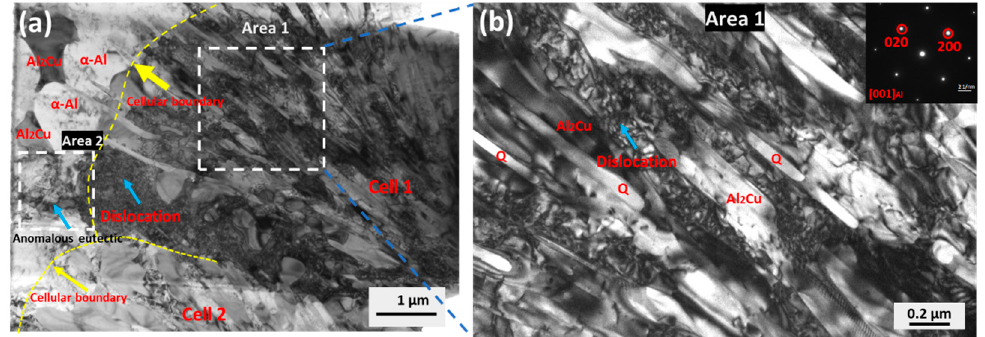
Figure 11. ( a ) bright-field TEM image of quaternary eutectic alloy after compression test ( b ) enlarged TEM BF images of cellular regions taken from Area 1.